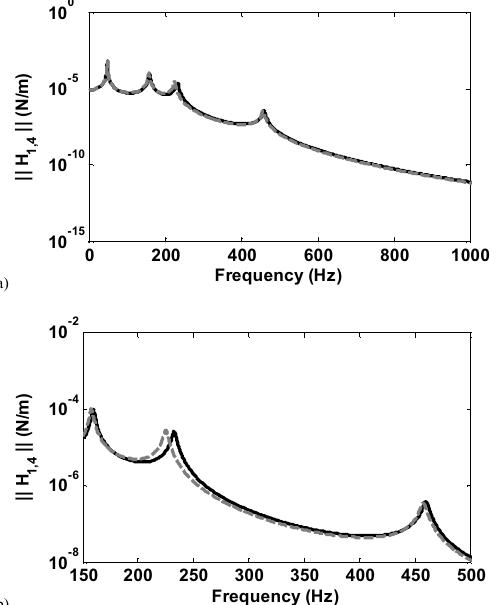
Fig. 3. Comparison of the healthy, trained FRF (——) and the damaged FRF (– – –) for a) a broad frequency range and b) a narrow frequency range.